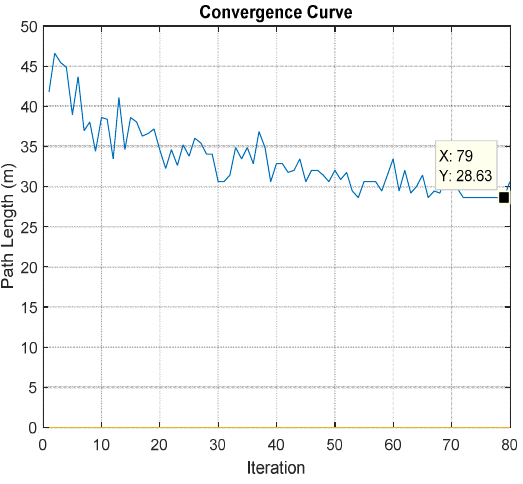
Fig. 13. The Convergence Curve for Experiment 2.